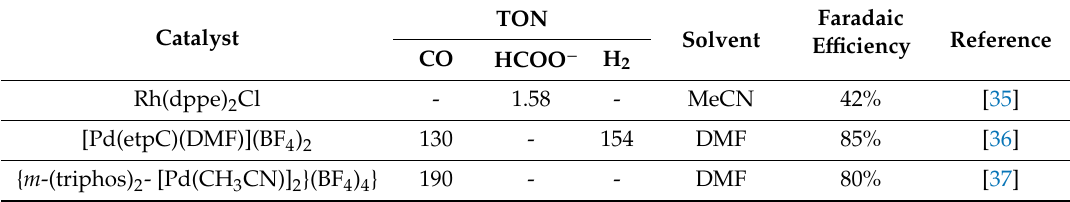
Table 2. Polyphosphine metal catalysts for two-electron CO 2 electroreduction. Polyphosphine metal catalysts for two-electron CO 2 electroreduction. bis(diphenylphosphino)ethane; triphos—bis(diphenylphosphinoethyl)phenylphosphine.